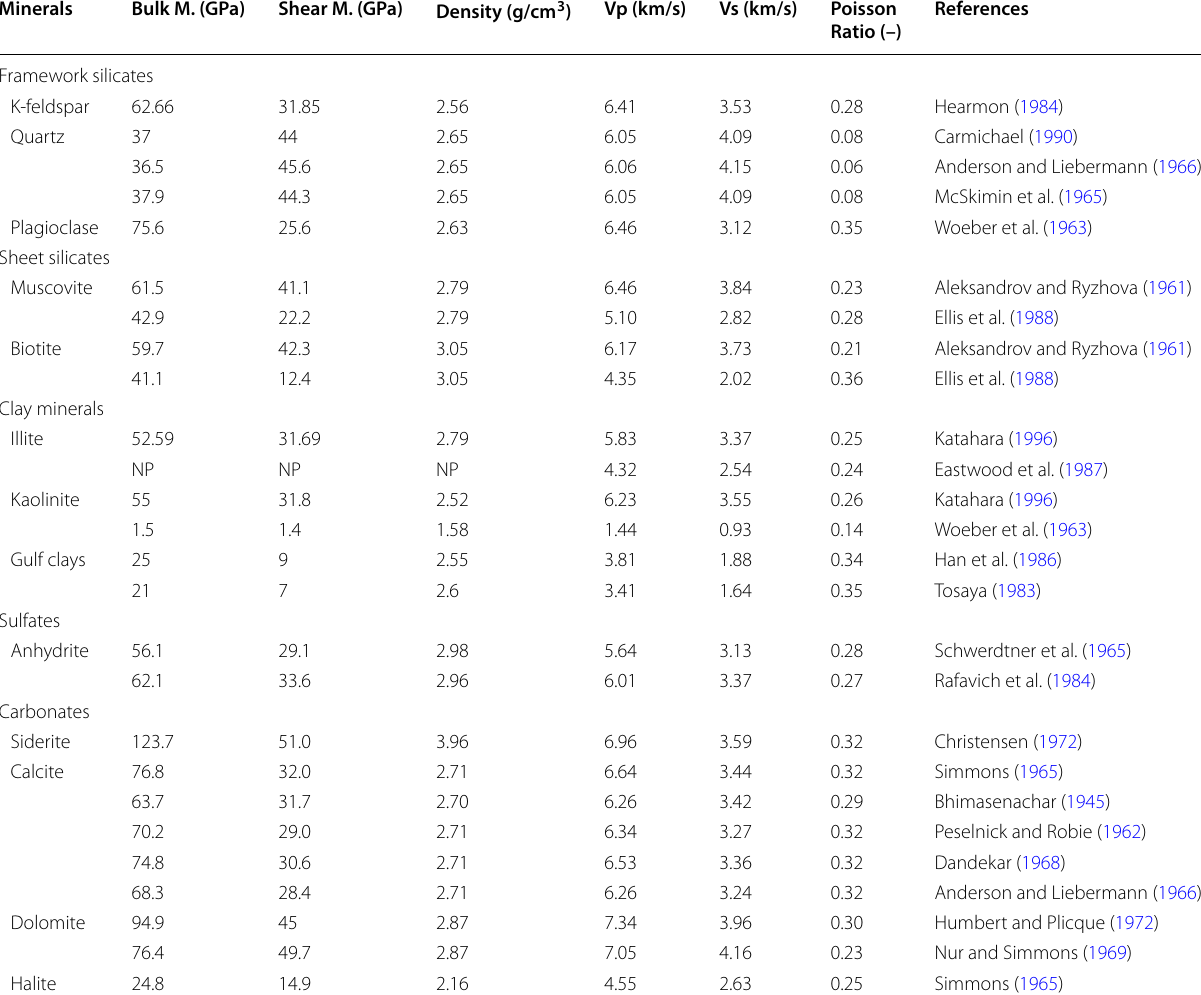
NP Not provided